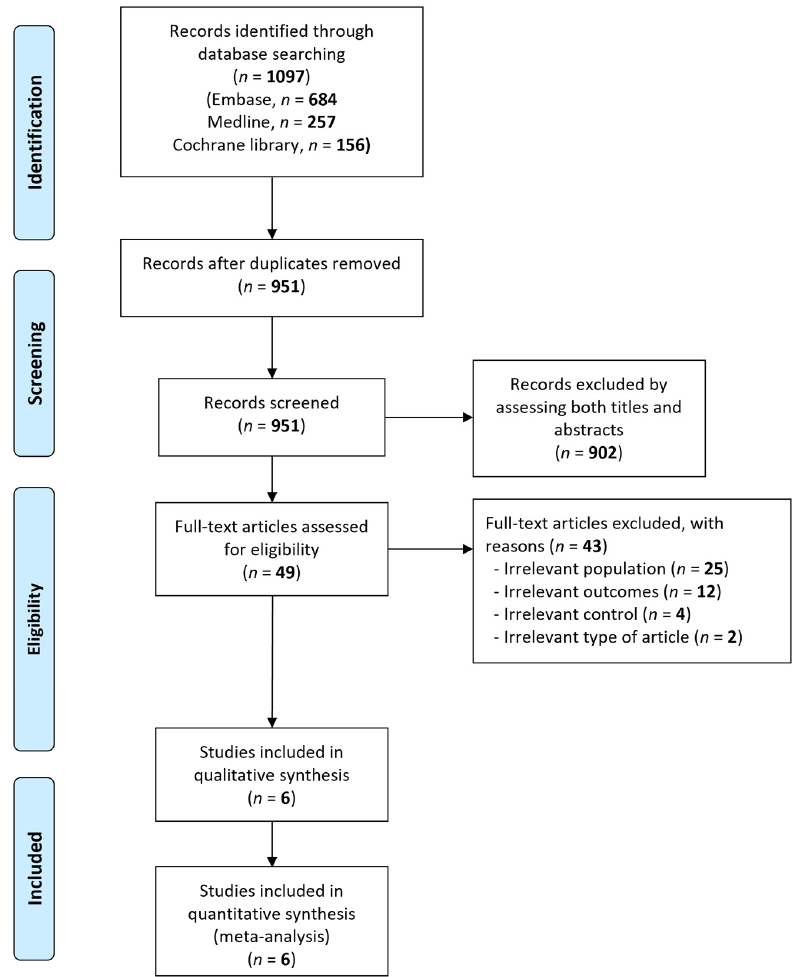
Figure 1. Flow diagram for the identification of relevant studies.